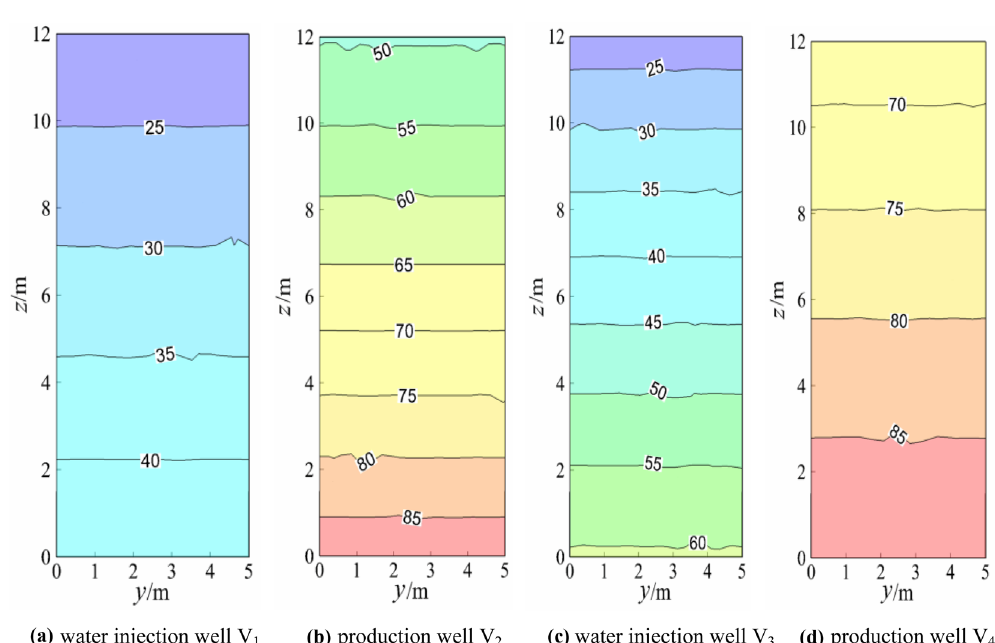
Figure 8. Temperature field of the geothermal well plane (working condition